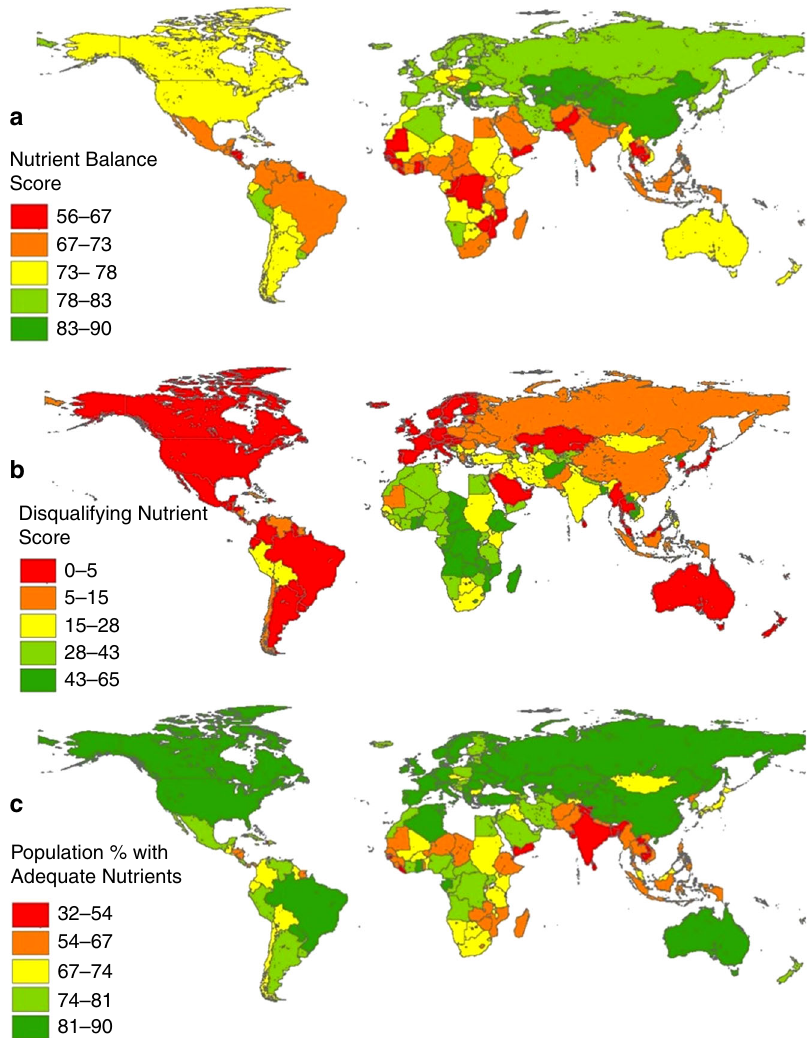
Fig. 1 Food nutrient adequacy indicator scores for 156 countries. a Nutrient Balance Score, b Disqualifying Nutrient Score, and c Population Share with Adequate Nutrients for all countries calculated in this study (year 2011). Countries for which data were not available do not appear on the map (e.g., Somalia). Symbology based on Jenks natural breaks classi fi cation method. See Supplementary Data 1 for all values per